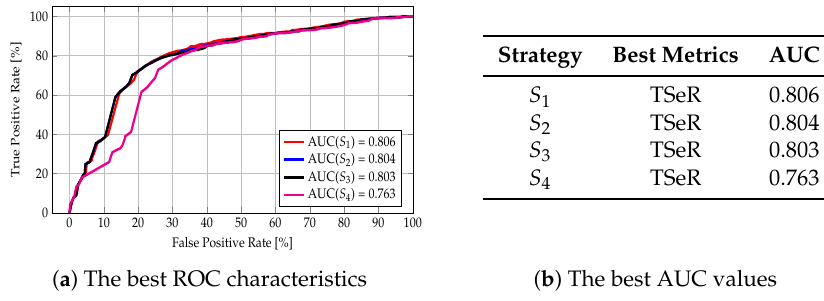
Figure 13. The best AUC values ( b ) and best ROC curves characteristics ( a ) for attribute Address